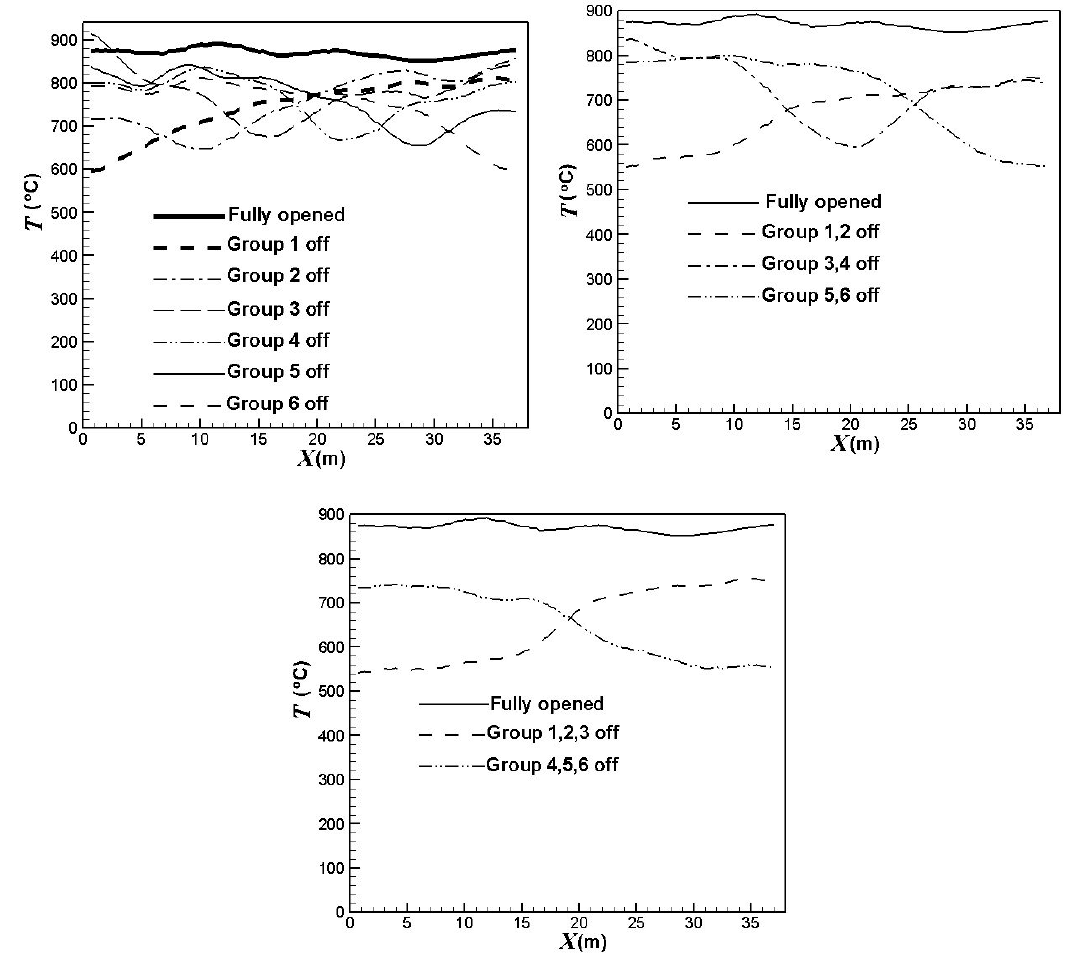
Figure 6. Outer surface average temperatures of the catalyst tubes using different burners on/off combinations. Figure 7 compares the effect of the burners on/off combinations on the outer surface temperature distributions of the catalyst tubes. It can be observed that the temperatures are higher at the lower portions of the catalyst tubes because of the weaker heat convec- tion near the bottom wall. Further, the upstream portion of the reformer has higher temperatures. This is because the top portion (roof) of the reformer is divergent and the reformer outlet position is at the right-hand side reformer roof. Therefore, the upper portion and downstream portion of the reformer have larger heat dissipation space while the upstream portion has smaller heat dissipation space and hence higher temper- atures. It is also observed that the thermal field is obviously influenced by the burners on/off combinations. For a reformer under normal operation, temperature is higher near the left-hand-side and right-hand-side walls because fluid motion is slow and heat dis- sipation is worse there. On the other hand, convection is better in the central area of the reformer. Therefore, turning off the burners near the left-hand-side and right-hand-side walls can mitigate the poor convection and hence yield a higher reduction in the catalyst tube temperatures. Further, heat transfer convected to the downstream area is reduced if the upstream burners are turned off; however, effect on the convection to the upstream area is minor if the downstream burners are turned off. Therefore, turning off the up- stream burners can yield greater temperature reductions than turning off the down- stream burners. ( a ) ( b )